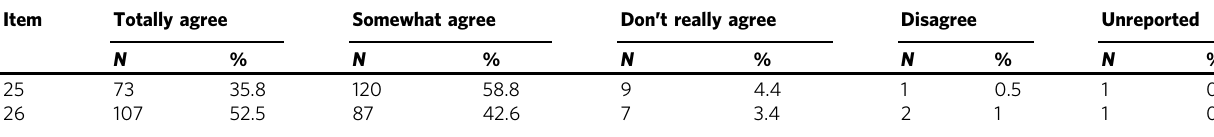
Table 5 Managing emotions.